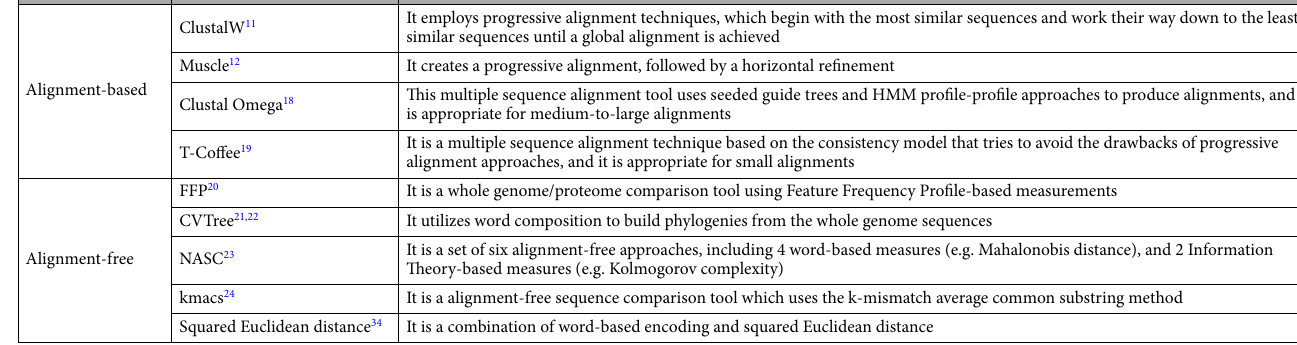
Table 1. A list of online tools developed for some of the alignment-based and alignment-free methods, as well as the summary of their comparison